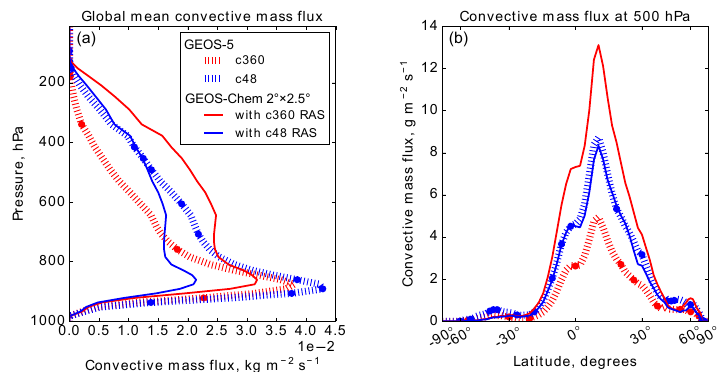
Figure 8. Convective mass fluxes for July 2013 produced by the GEOS-5 GCM at cubed-sphere c360 ( ≈ 25km) and c48 ( ≈ 200km) resolution using the Relaxed Arakawa–Schubert (RAS) scheme and by the 2 ◦ × 2.5 ◦ ( ≈ 200km) GEOS-Chem simulation using the RAS scheme with c360 and c48 GEOS-5 meteorology. (a) Vertical profile of global mean convective mass flux. (b) Zonal mean convective mass flux at 500hPa as a function of